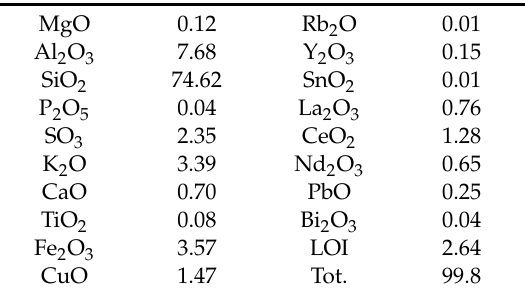
Table 1. EDXRF Bulk Composition (wt%) of a Representative Fluorcarbonate-Bearing Quartz Dike